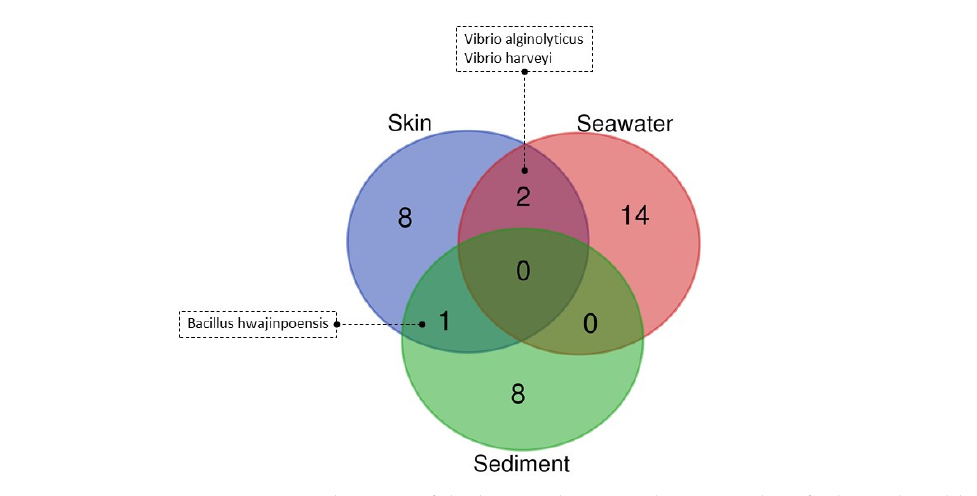
Figure 3. Venn diagram of the bacterial species that were identified in culturable microbiota of fish skin, seawater, and sediment associated with the NAS marine fish farm. At the MAS farm, 20 isolates out of 64 in total were isolated from the European seabass swabs, while 22 accounted for seawater and sediment isolates. A total of 22 bacterial species were identified among the isolates from all the sample types in the MAS farm (Table 5). Despite the difference of species number (Table 5) among the bacterial commu- nities of the fish skin (11 species), seawater (3 species), and sediment (4 species), species Marinobacter litoralis , and two species from the genus Pseudoalteromonas ( Pseudoalteromonas tetraodonis , Pseudoalteromonas undina ) were detected in the seawater and sediment, whereas V . toranozoniae was identified in the skin and sediment (Figure 4). Table 5. Results of molecular identification of the bacterial isolates from the MAS conventional